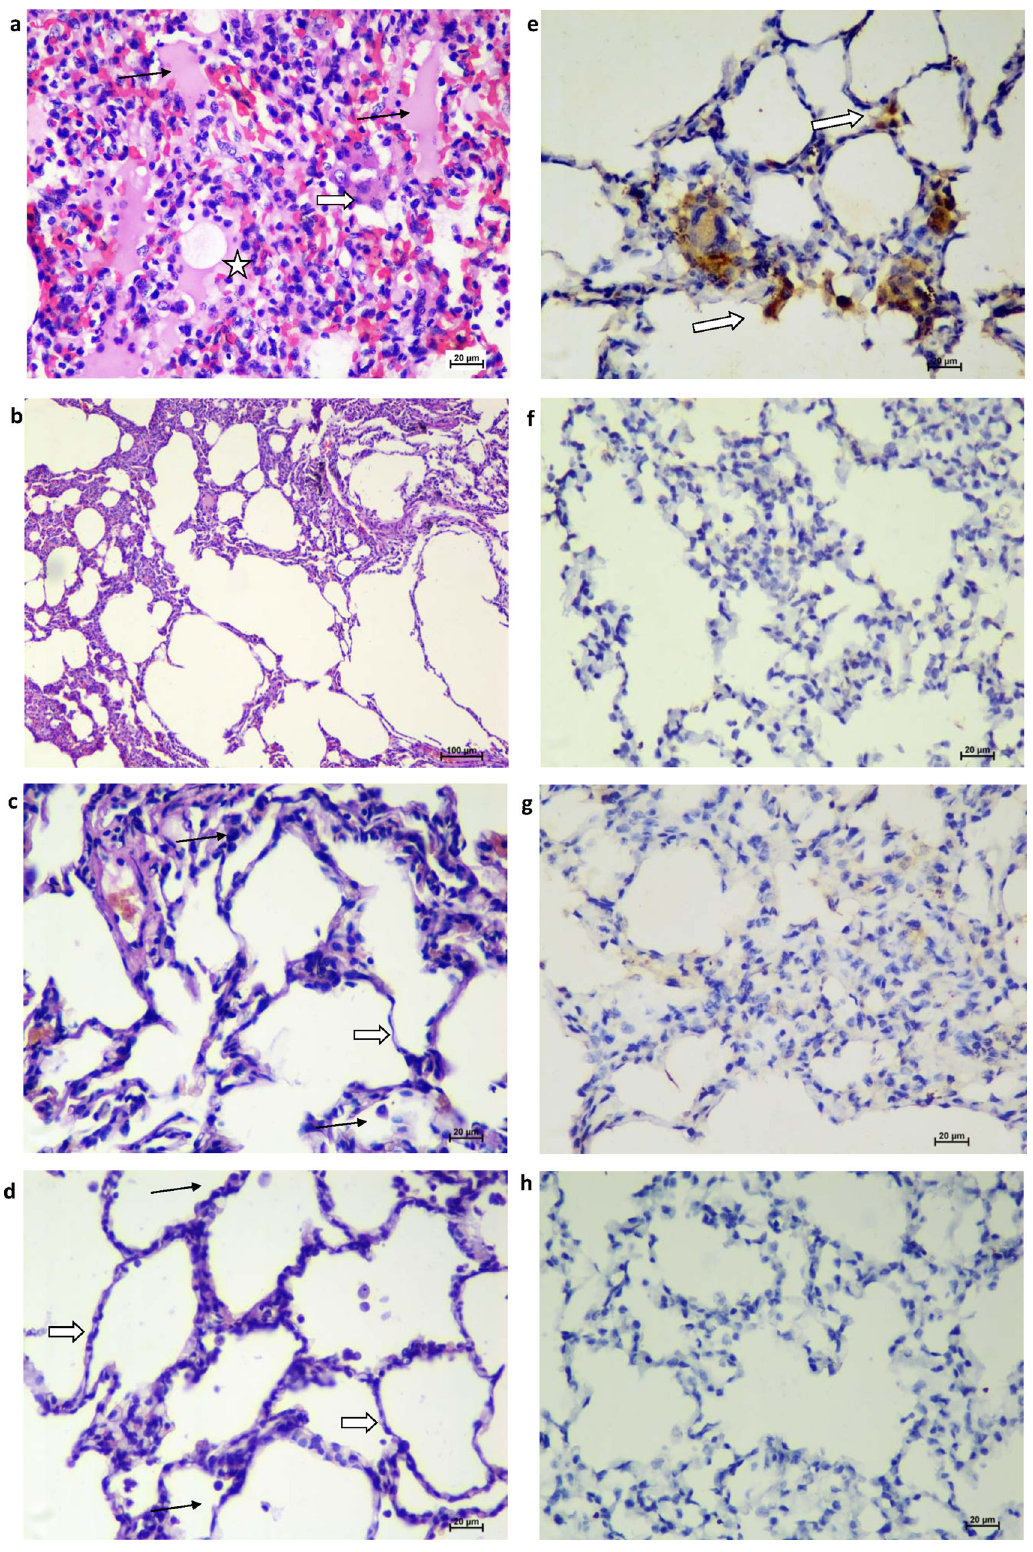
Enzyme-linked immunosorbent assay for detection of anti-SARS-CoV-2 IgG antibody . Immunoplates (Maxisorp, Nun) were coated with 100µl/well of SARS- CoV-2 antigen overnight at 4 °C in the carbonate buffer. Subsequently, wells were blocked with liquid plate sealer (CANDOR Bioscience GmbH, Germany) for 2 h at room temperature) 25 – 30 °C. One-hundred microlitres of diluted rhesus macaque serum sample 1:100 in 1% bovine serum albumin in 1× PBS containing 0.1%